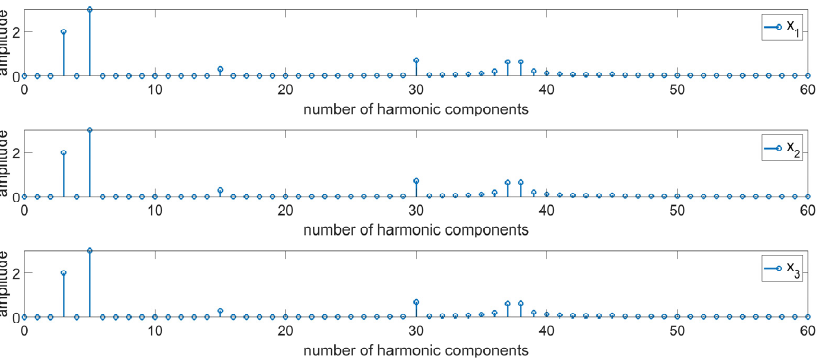
Figure 5. Amplitude spectral density.